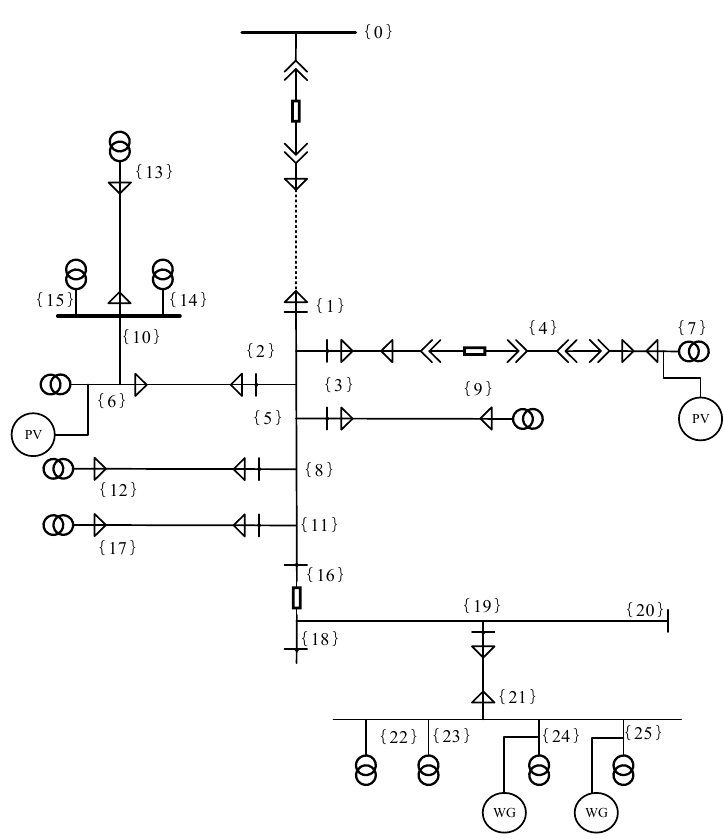
Figure 5. The structure drawing of a distribution network.